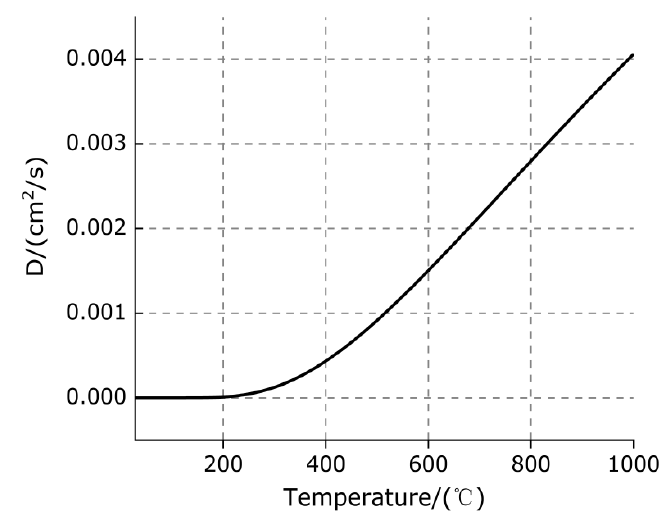
Figure 8. The diffusion of H in metal Ti varies with temperature.